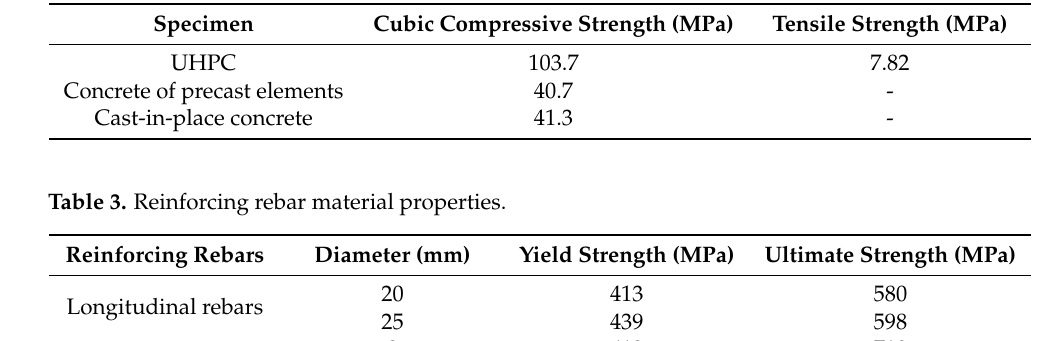
Table 2. Concrete material properties.